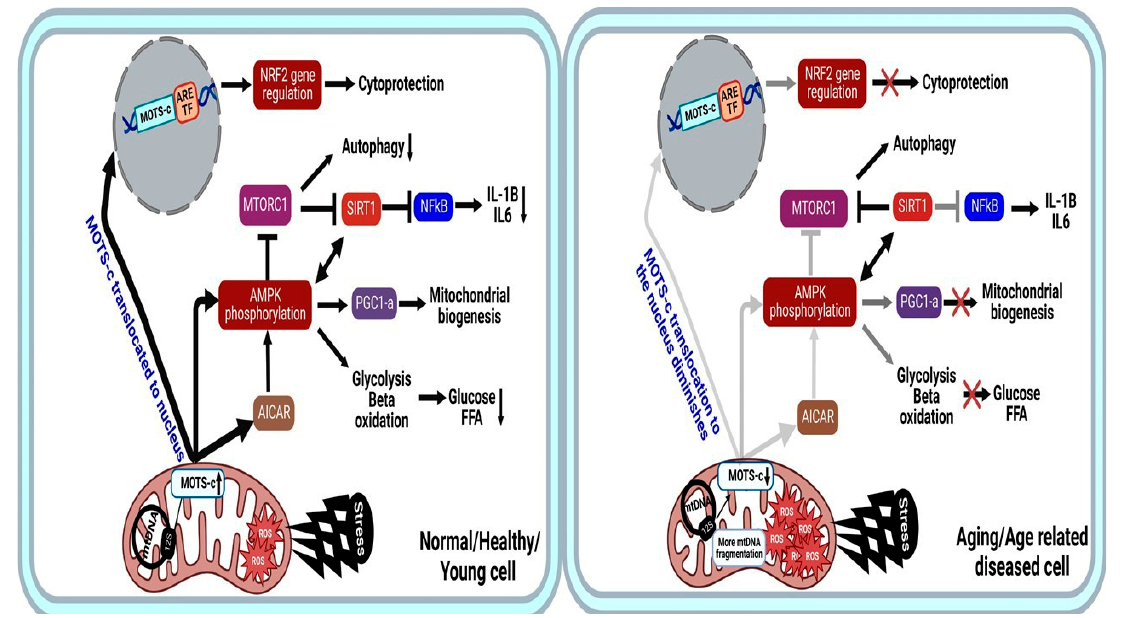
Figure 3. MOTS-c mechanism of action in normal young healthy state (left) vs. Aging or age-related diseases (right). The peptide is capable of interacting with the nuclear genome to provide cryoprotection and has beneficial effects mainly when it comes to the regulation of the metabolisms of AMPK and AICAR. Faded lines indicate less dependent effect or production, Faded line with cross indicate signal is completely lost, and cross indicates signal is lost. AMPK, 5 ′ -Adenosine Monophosphate-activated Protein Kinase; AICAR, 5-AminoImidazole-4-CarboxAmide Ribonucleotide; FFA, Free Fatty Acid; FFA-B, Free Fatty Acid-B oxidation; ARE, Antioxidant Response Elements, TF-Transcription factor.